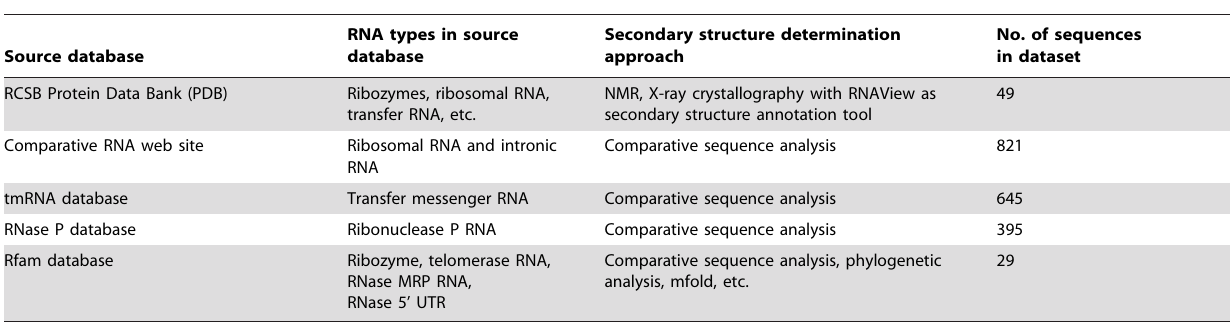
Table 1. Composition of the experimental dataset obtained from RNA STRAND.